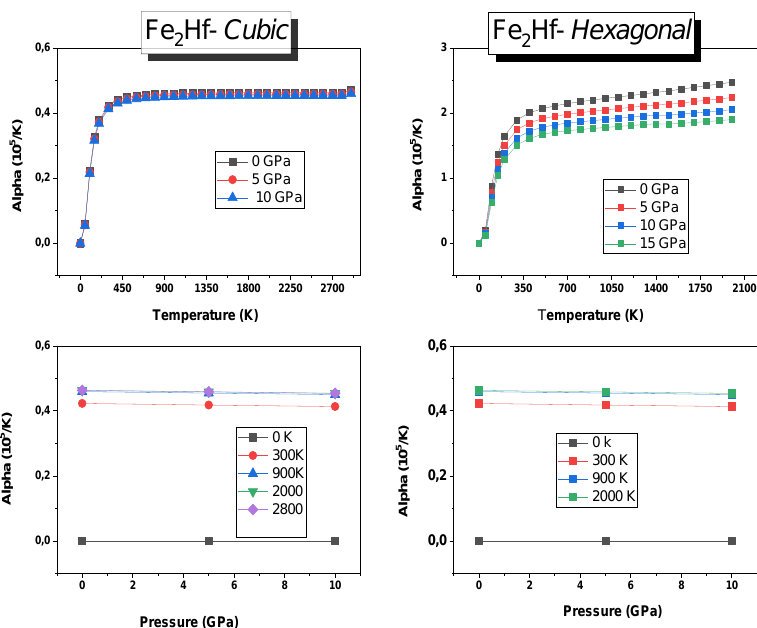
Fig. 11. Variation of volume expansion coefficient 𝛼 with temperature T and pressures for c- Fe 2 Hf and h- Fe 2 Hf (upper panel),